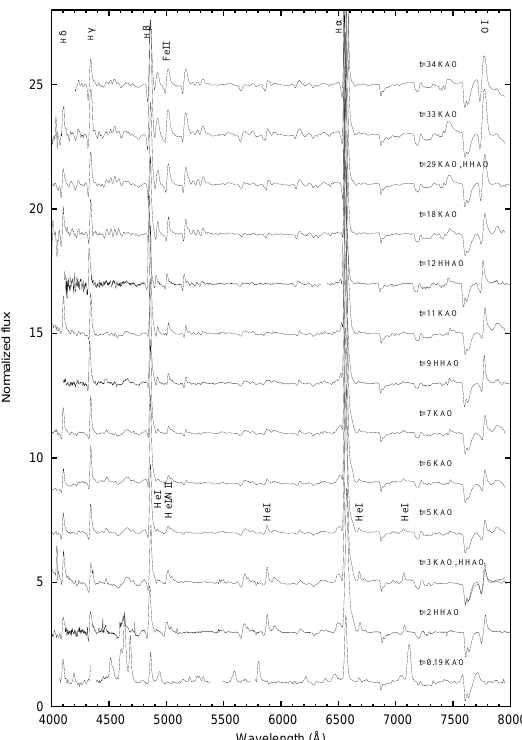
Figure 3: Low resolution spectra of T Pyx from t = 0 . 19 – 34 d. Observations were carried out at Koyama Astronomical Observatory (KAO) and Higashi-Hiroshima Astronomical Observatory